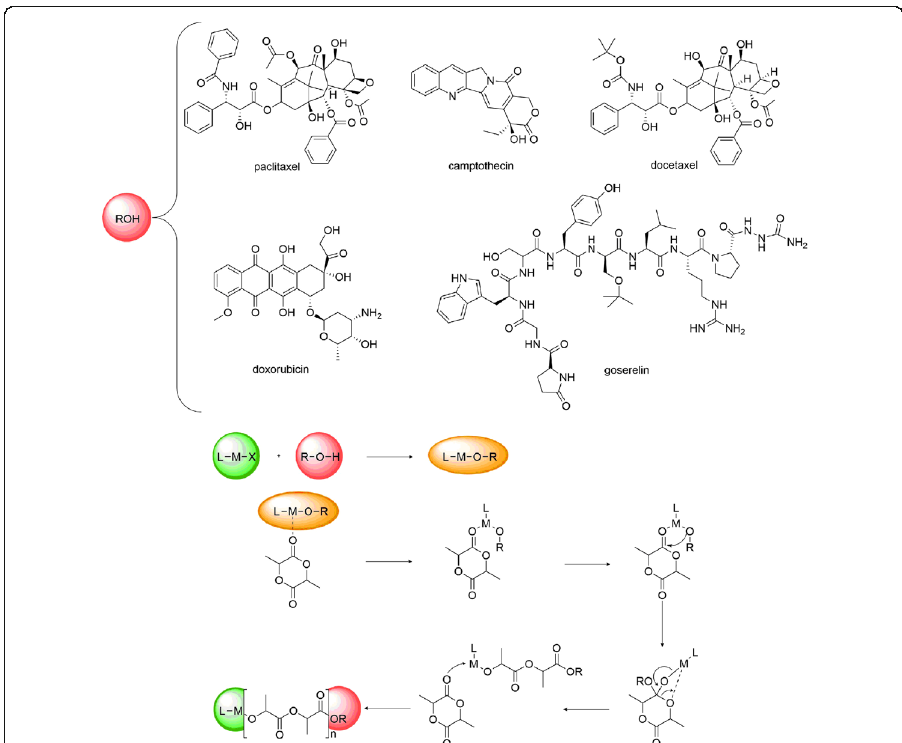
Fig. 7 Drug-initiated methodology for the synthesis of polymer-drug